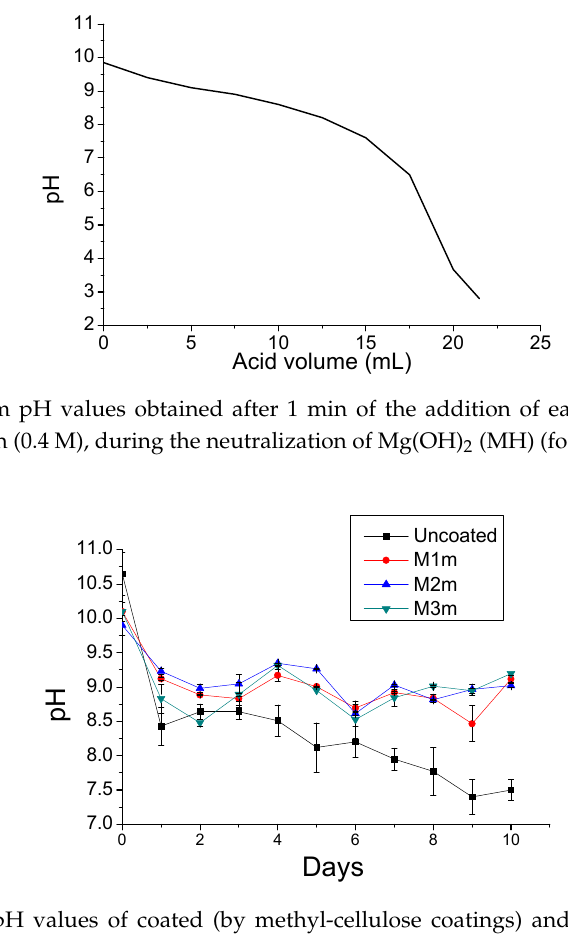
Figure 7. Surface pH values of the concrete specimens sprayed daily with 17% of the reaction’s stoichiometry: ( a ) thin layer, and ( b ) thick layer of coating. The data points and the error bars denote the mean and the standard deviation, respectively.